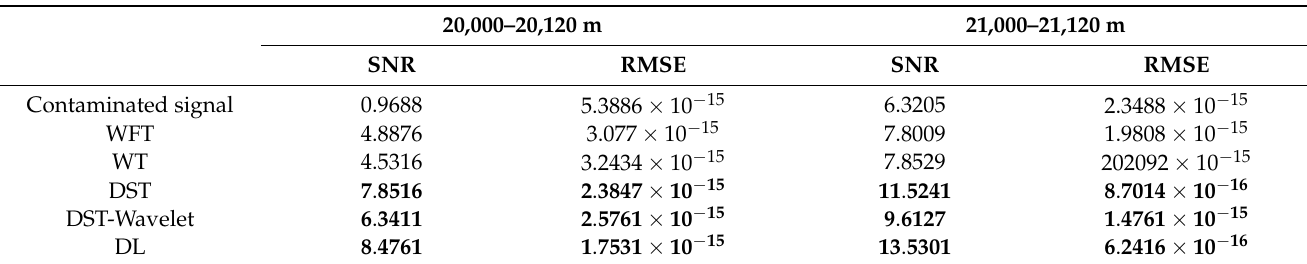
Table 1. The comparison of different denoising